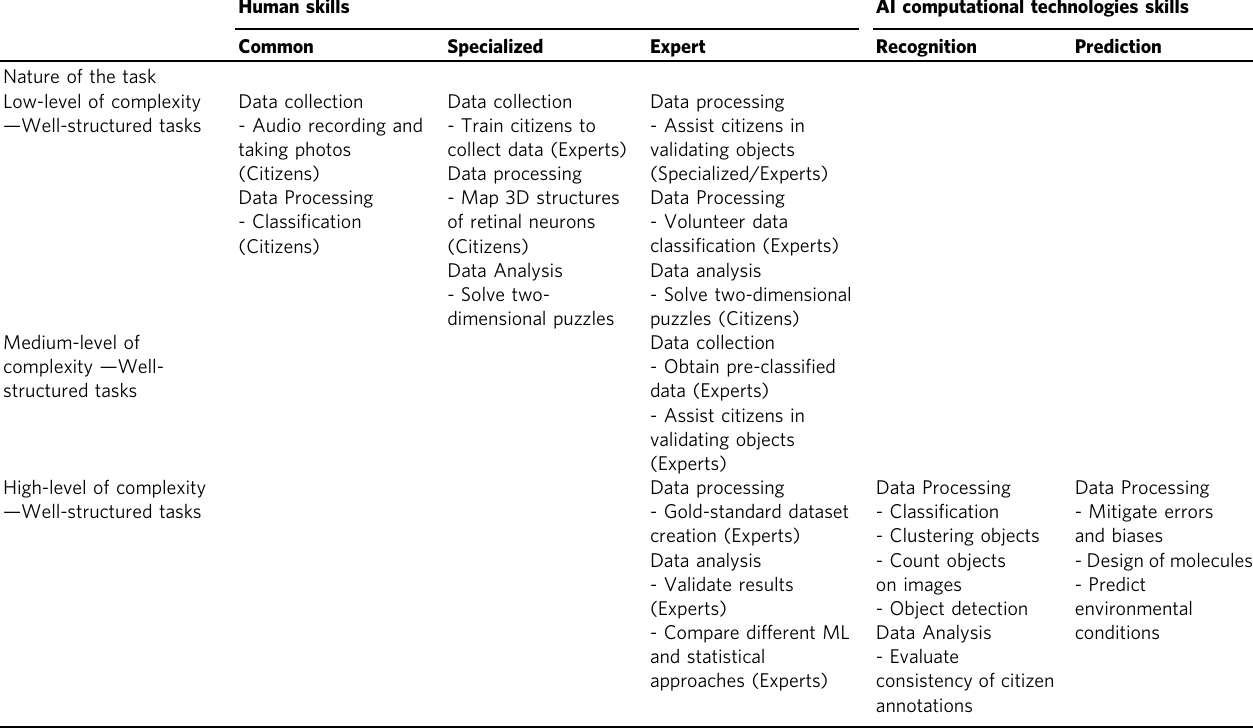
Table 8 Project pro fi le matrix —